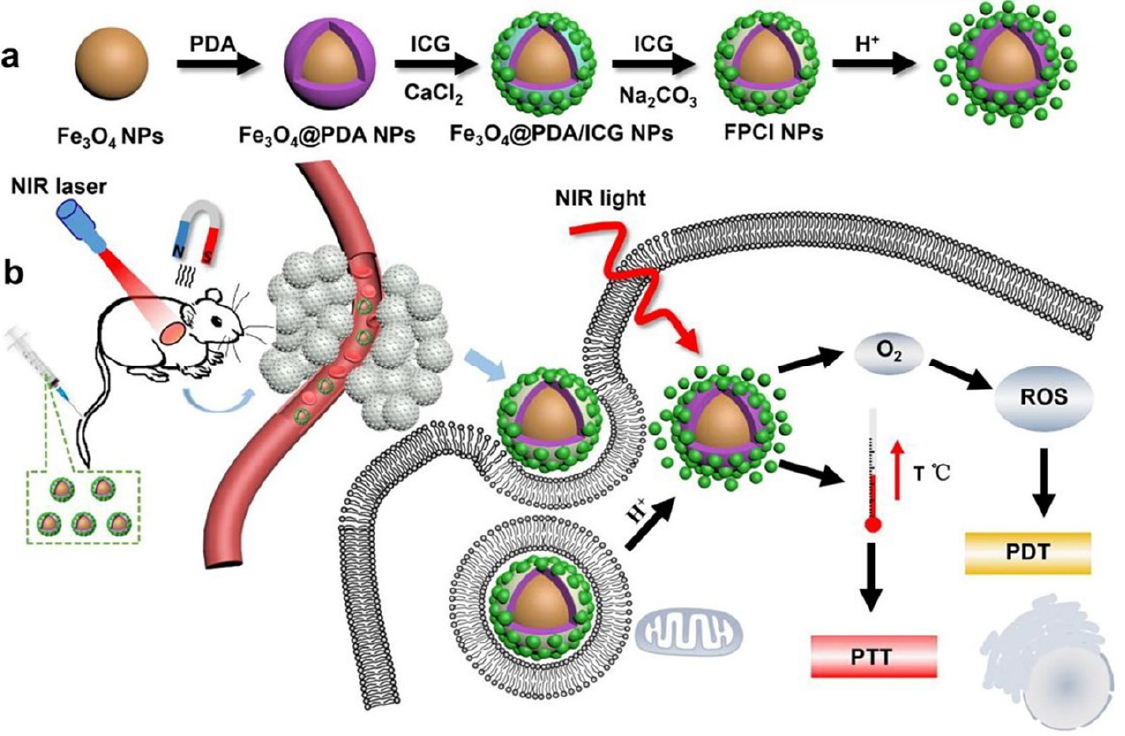
Figure 4. Schematic of the preparation process ( a ) and PTT/PDT treatment ( b ) of FPCI NPs. Re- printed with permission. Copyright 2018, Elsevier [30]. with permission. Copyright 2018, Elsevier